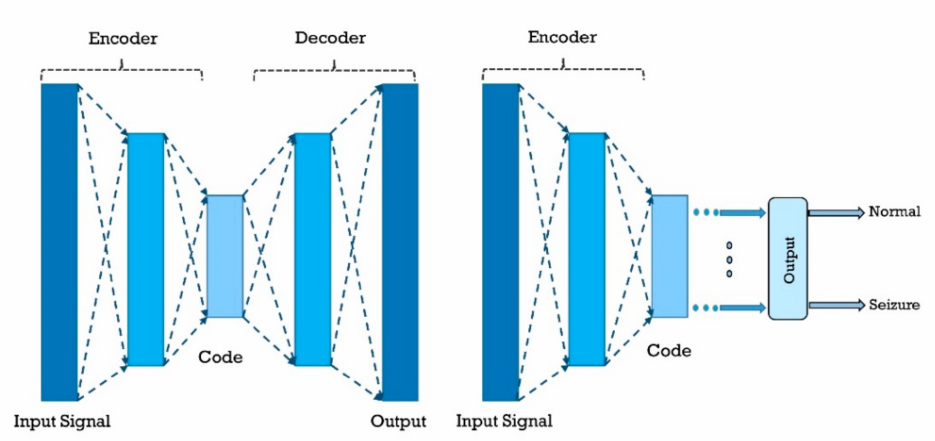
Figure 12. Sample AE network that may be used for seizure